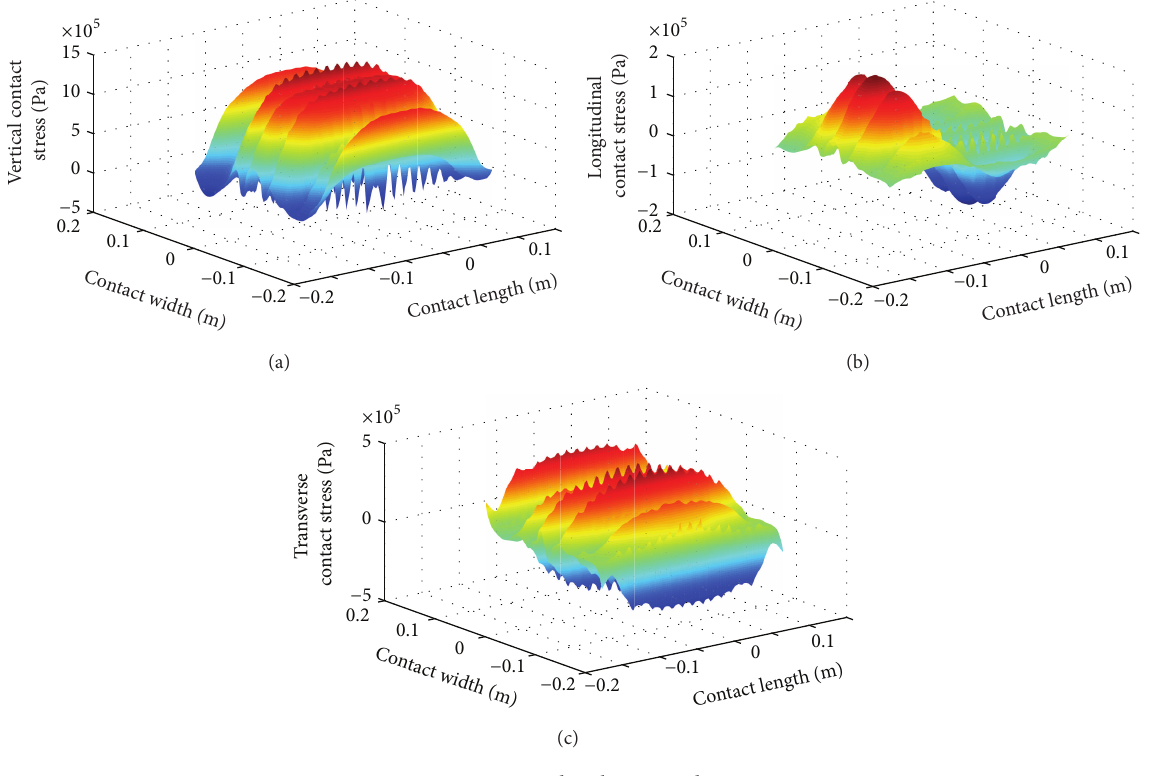
Figure 12: Contact stress distribution under static state.